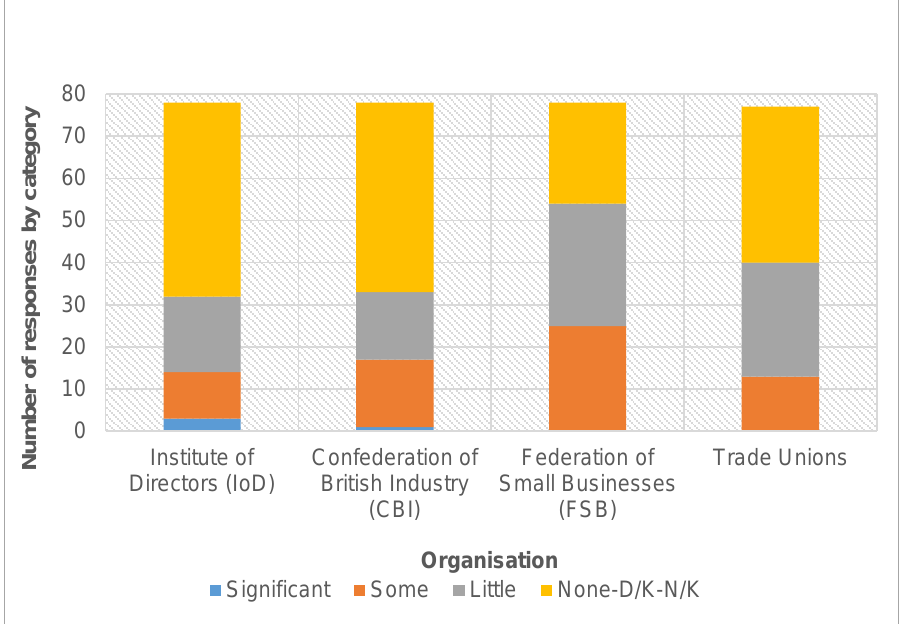
Figure 5: Participants’ assessments of loci of influence over rural policy in West Dorset ‘business’